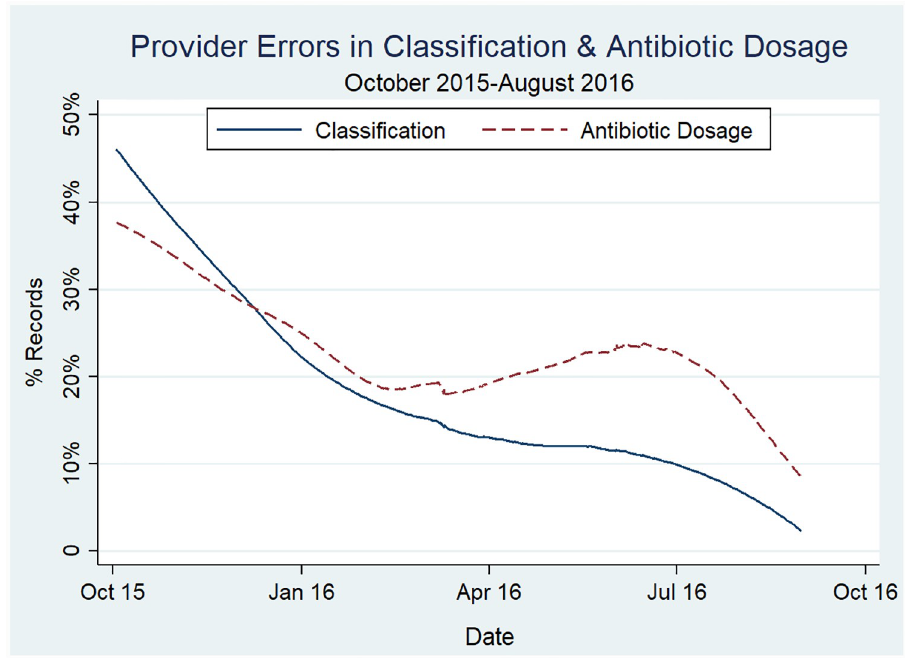
Fig 3. Provider errors in classification and treatment over the study